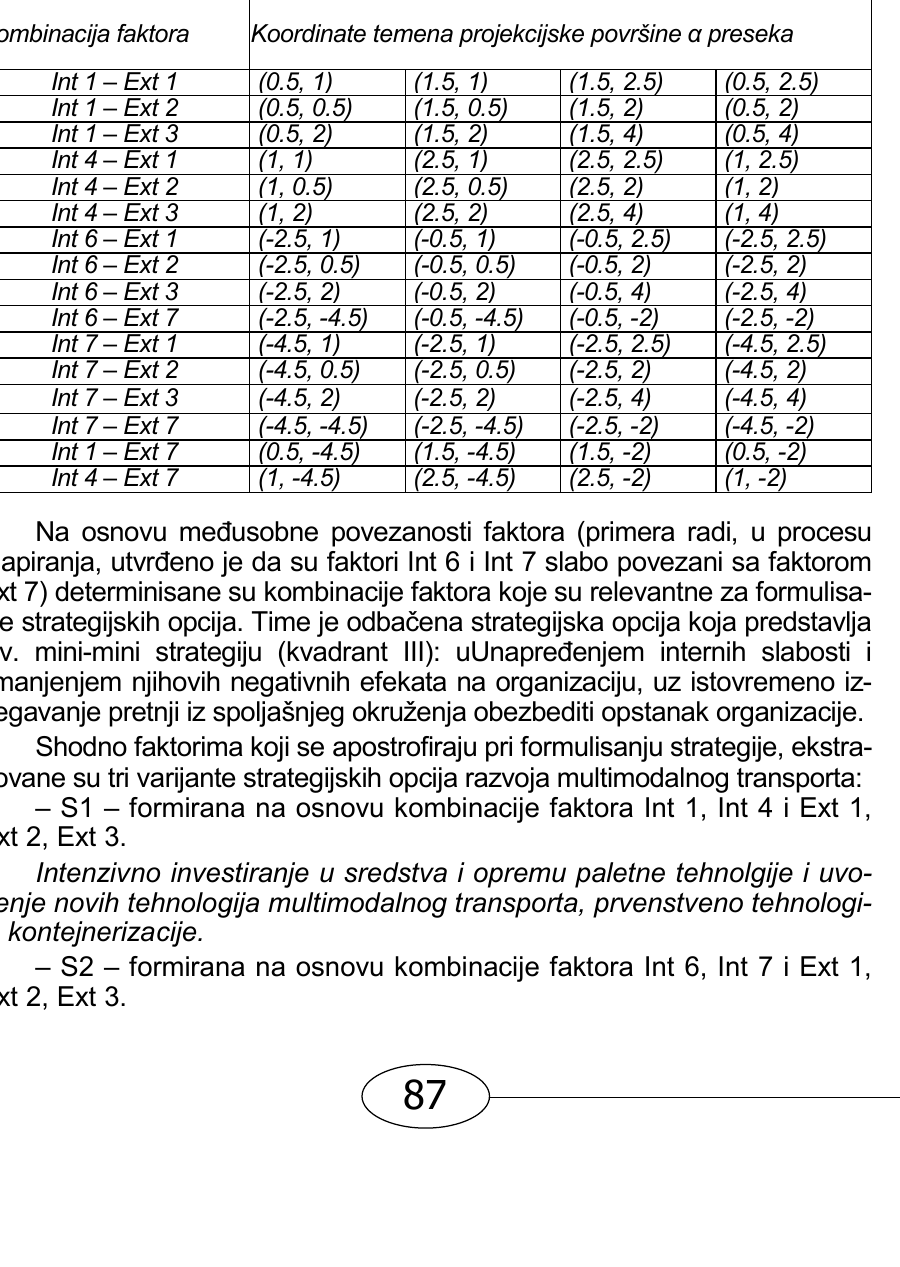
Table 2 – Coordinates of the vertices of the α -cut projection surfaces of the relevant factor combinations Kombinacija